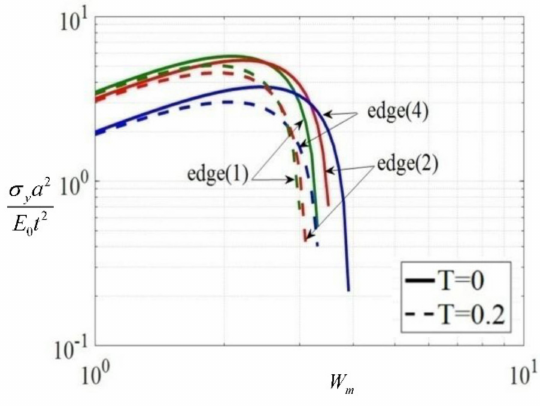
Figure 8. Local variations of σ y a 2 / E 0 t 2 with W m at the